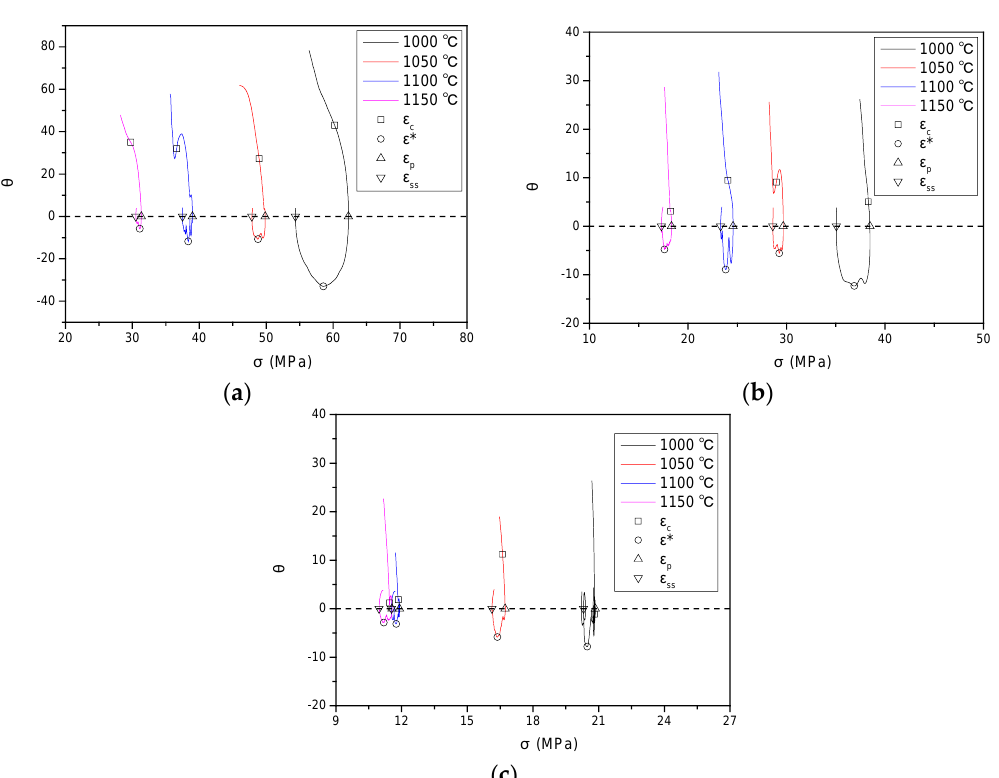
Figure 3. The curve of 𝜃⁡vs. 𝜎 at 1150 °C and 𝜀̇ = 1 s −1 .